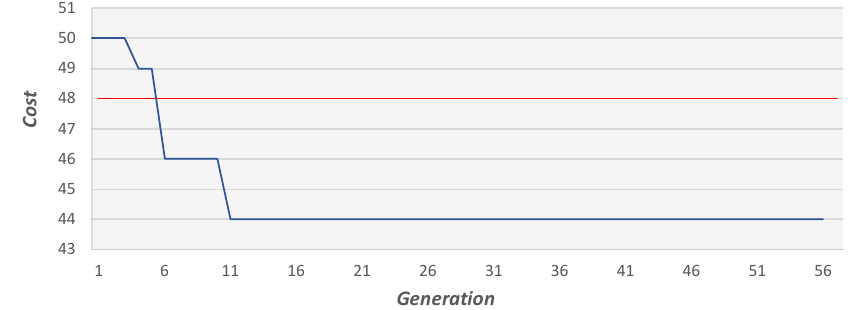
Figure 25. The cost reduction of the GA over 60 generations on an example problem. The fixed red line represents the result of the 2-factor approximation